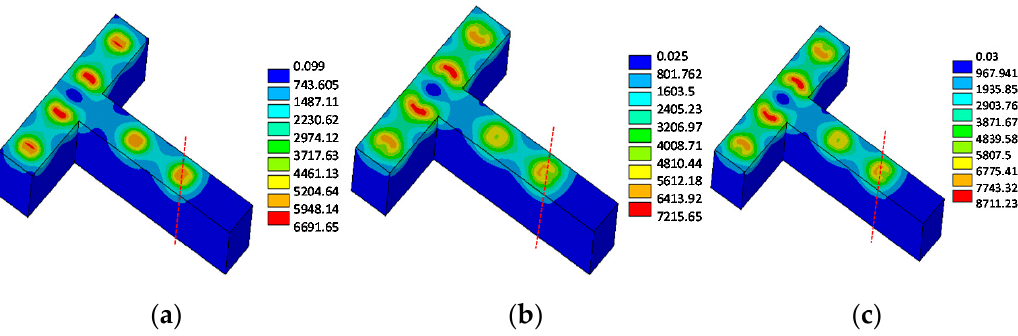
Figure 9. Distribution of magnetic energy density: ( a ) 100 A, ( b ) 150 A, ( c ) 200 A (unit: J/m 3 ).